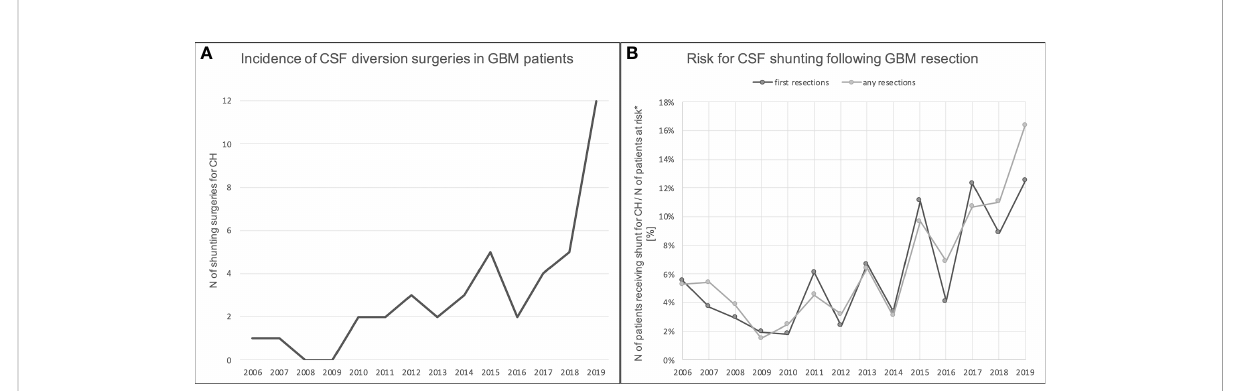
FIGURE 4 Incidence of and risk for CSF shunting for CH following tumor resection in GBM patients between 2006-2019. (A) shows the total number of shunting surgeries for CH in GBM patients per year. There was an increasing trend over the years. (B) At the same time, there was an increasing trend in the risk for the development of CH following GBM resection (both fi rst resections and re-resections). *at risk = patients who do not have a shunt